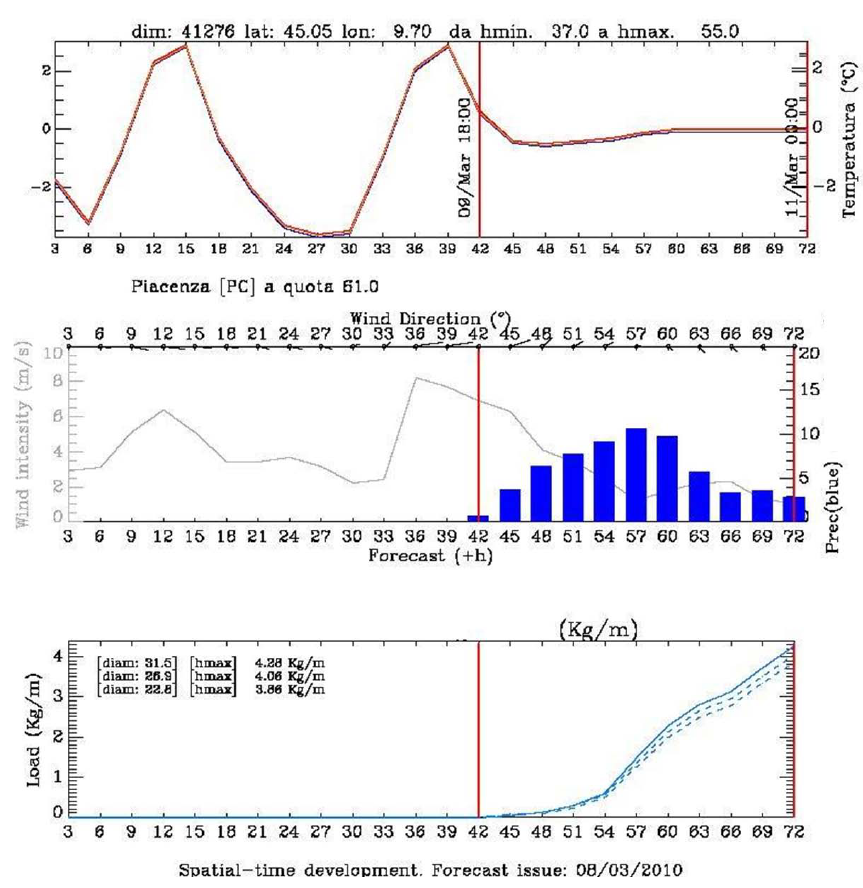
Fig. 5. Time diagramme referred to the Piacenza case on 08–10 March